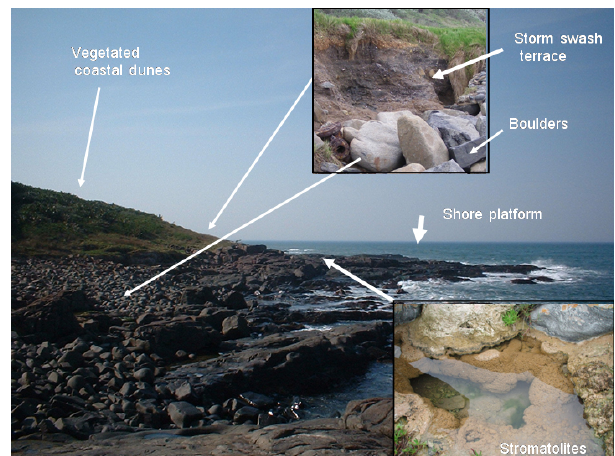
Figure 6. (a) Sandstone shore platform and boulder ridge at Luphatana, South Africa. Stromatolites are growing in the pool (see black arrow); 80t boulders are present in the boulder ridge showing the contrasting shore platform environmental extremes. (b) Tofo, Mozambique, tufa shore platform with scattered large boulders. (c) Giant’s Causeway basalt shore platform and cliffs. (d) Lewisian gneiss shore platform at Luskentyre Bay, Harris, UK – Note the peat marsh (P).